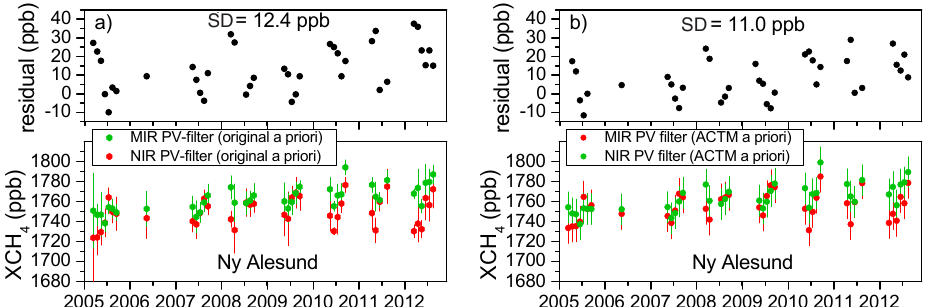
Figure C2. Same as Fig. 2 for Ny-Ålesund but excluding retrievals affected from stratospheric subsidence via PV as an extra filter criterion (see Sect. 4.1.2). (a) NIR and MIR retrievals with their original standard retrieval a priori profiles. (b) NIR and MIR retrievals corrected to the common ACTM a priori profile.